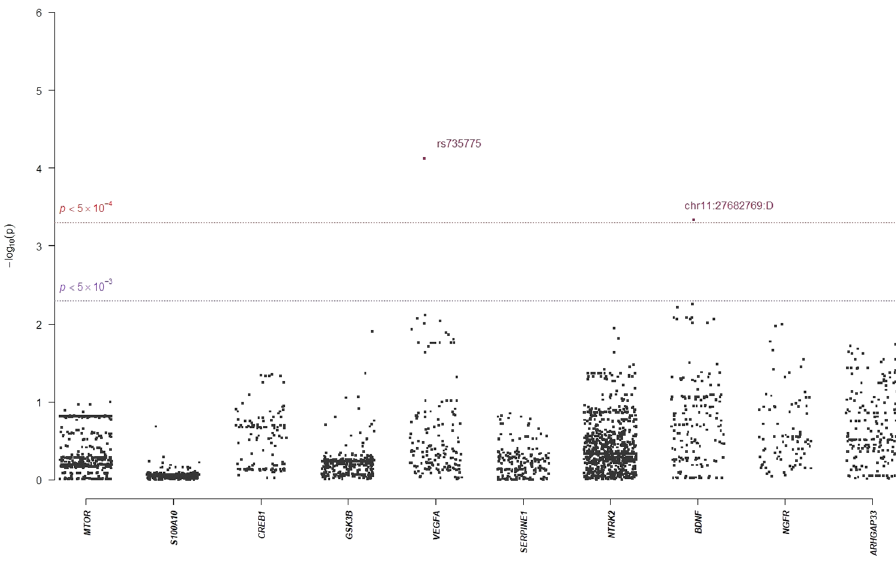
Figure 1. Manhattan plot of meta-analysis of selected candidate genes for Remitted (Score).